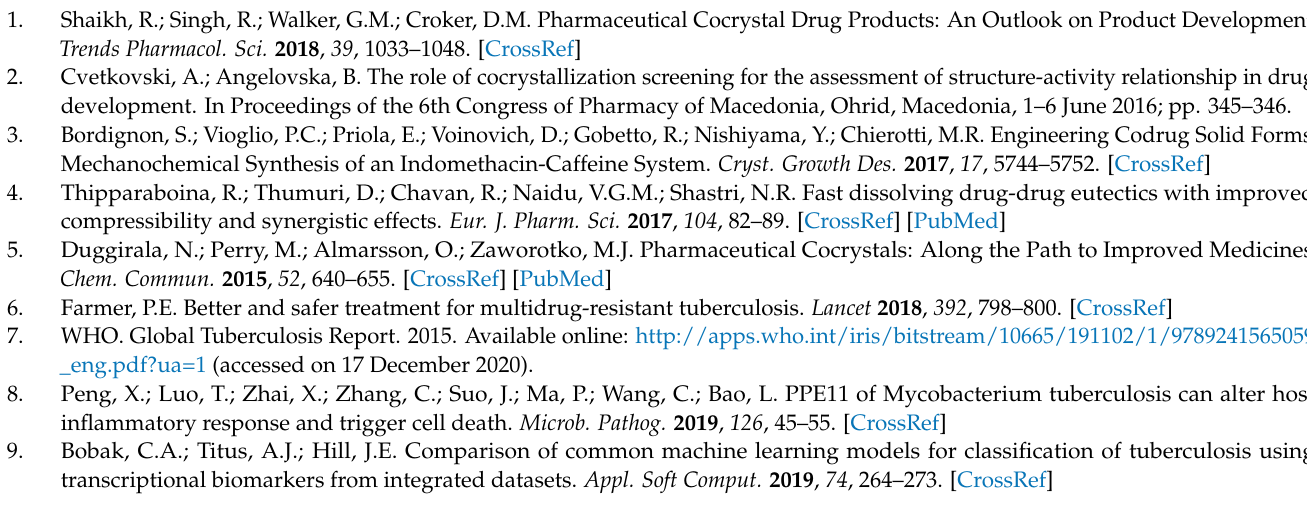
Figure S4: DSC thermograms of the cocrystals. Figure S5: Thermogravimetric analysis (TGA) plot of the cocrystals and 4-ASA. Figure S6: Dynamic light scattering (DLS) size distribution by intensity. Figure S7: SMT dissolution. Table S1: SMT absorbance measurements at 244 and 299 nm. Table S2: 4-ASA absorbance measurements at 244 and 299 nm. Table S3: Hydrodynamic diameter of the